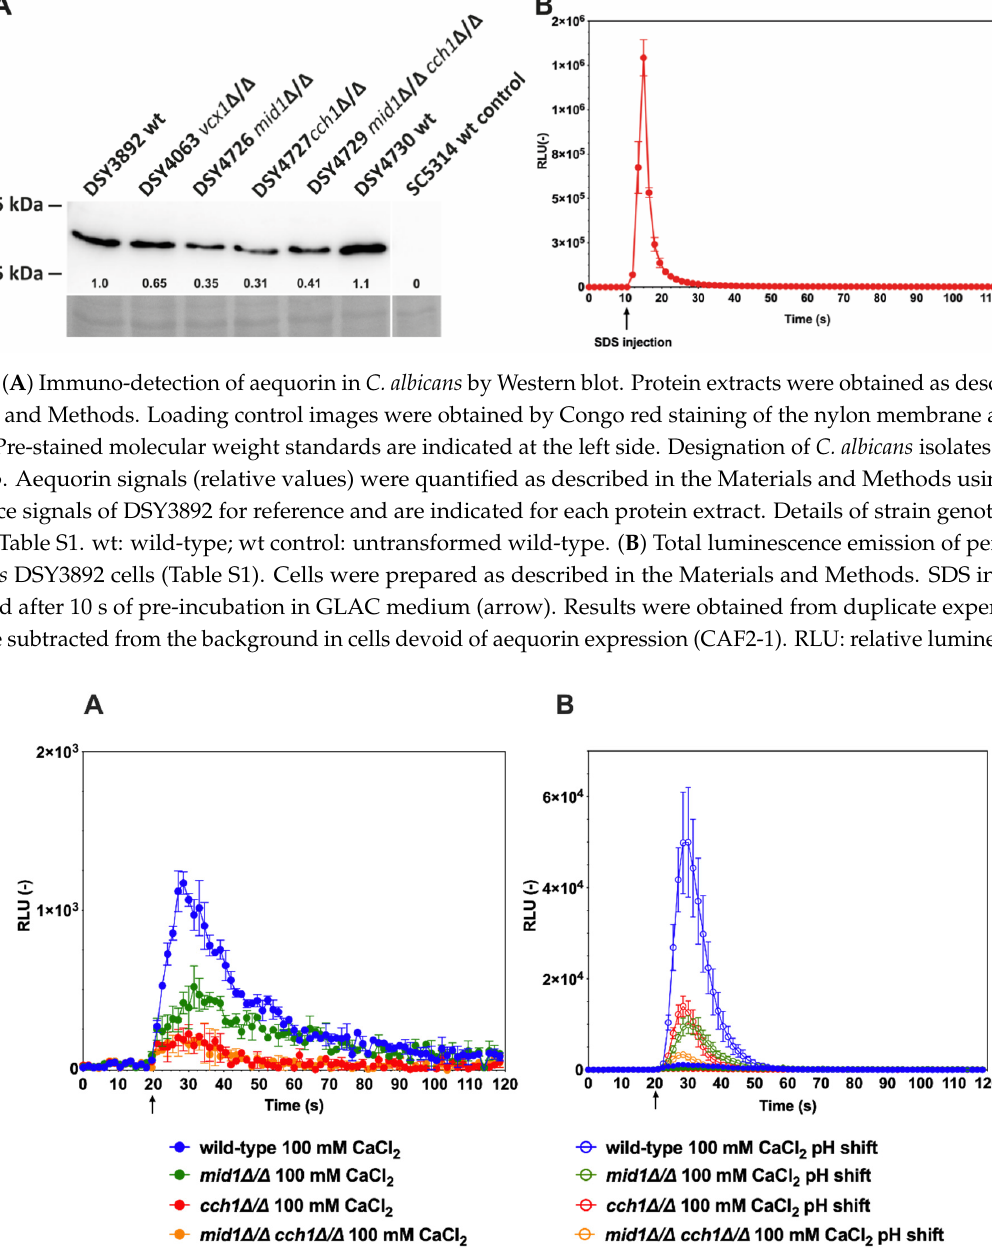
Figure 2. Alkaline stress induces a calcium spike in C. albicans . ( A ) Addition of 100 mM CaCl 2 only. DSY3892 was used as the wild-type control strain. DSY4726, DSY4727 and DSY4729 ( mid1 ∆ / ∆ , cch1 ∆ / ∆ and mid1 ∆ / ∆ cch1 ∆ / ∆ ) mutant cells were prepared as described in the Materials and Methods. Injection of CaCl 2 (1 M) was performed after 20 s of pre-incubation in GLAC medium (arrow). Results were obtained from duplicate experiments and data were subtracted from background cells devoid of aequorin expression (CAF2-1). Comparisons of RLU values between the CaCl 2 -treated wild-type and mutants were significant ( p < 0.001) after injections and after up to 50 s of experiment time had elapsed. Comparisons of RLU values between the CaCl 2 -treated mutants were not significant. ( B ) Addition of 100 mM CaCl 2 and pH shift. Injection of 0.25 M Tris-HCl (pH 7.5) and CaCl 2 (1 M) were performed after 20 s of pre-incubation in GLAC medium (arrow). Comparisons of RLU values between the CaCl 2 -treated cells and alkaline conditions were significant ( p < 0.001) after injections and up to 30 to 50 s of experiment time had elapsed. Comparisons of RLU values between the wild-type and mutants under alkaline conditions were significant ( p < 0.001) and up to 50 s of experiment time had elapsed. Comparisons of RLU values under alkaline conditions between mutants were significant ( p < 0.001) up to 40 s of time had elapsed between the mid1 ∆ / ∆ cch1 ∆ / ∆ mutant and single mutants, although not significant between single mutants. Data in the y -axis are shown at a higher scale as compared to panel